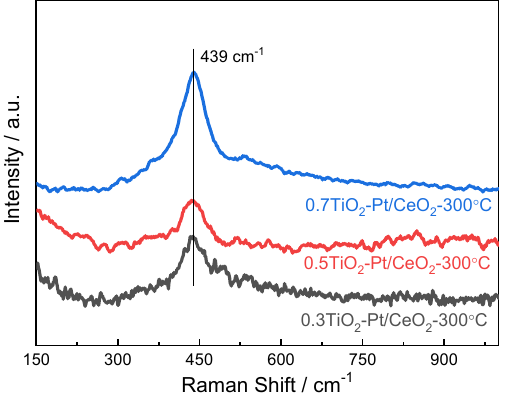
Figure 6. Raman spectra of (TiO 2 − Pt)/CeO 2 catalysts.